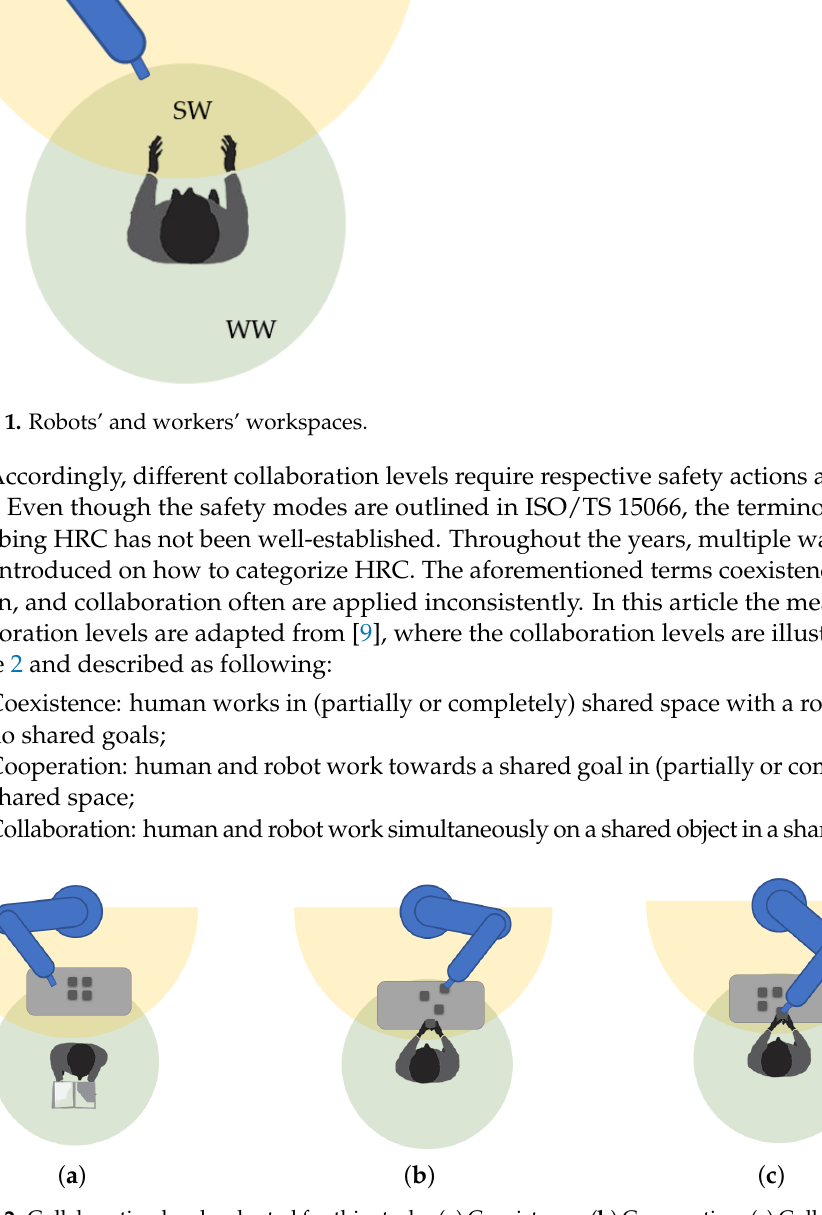
Figure 2. Collaboration levels adapted for this study: ( a ) Coexistence; ( b ) Cooperation; ( c )